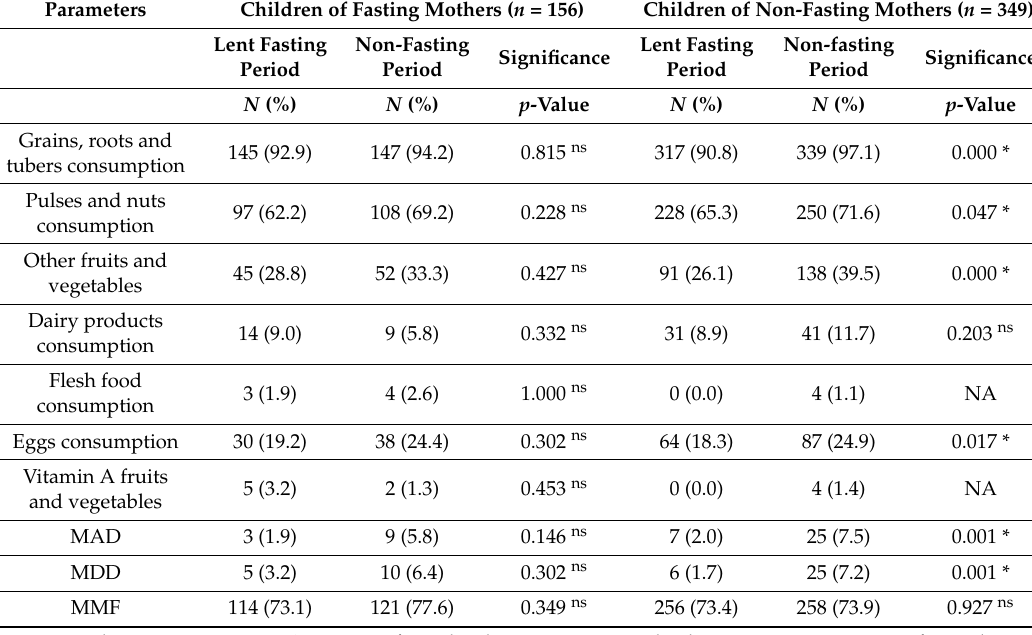
Table 4. Food consumption pattern of 6–23-month-old children of fasting and non-fasting mothers during lent fasting and non-fasting periods in rural Tigray, Northern Ethiopia. Parameters Children of Fasting Mothers ( n = 156) Children of Non-Fasting Mothers ( n = 349) Lent Fasting Non-Fasting Lent Fasting Non-fasting Significance Significance Period Period Period Period